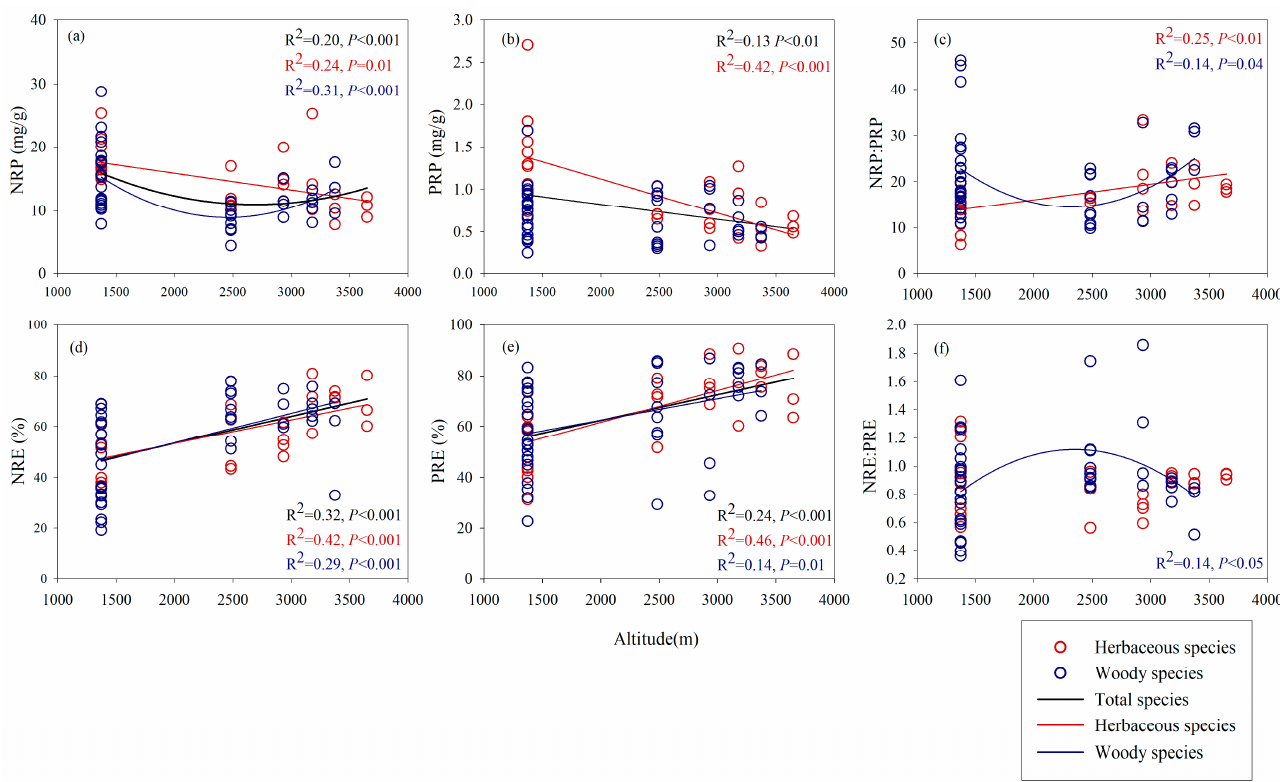
Figure 3. Altitudinal patterns of leaf N and P resorption traits. ( a ) Altitudinal patterns of leaf NRP. ( b ) Altitudinal patterns of leaf PRP. ( c ) Altitudinal patterns of leaf NRP:PRP. ( d ) Altitudinal patterns of leaf NRE. ( e ) Altitudinal patterns of leaf PRE. ( f ) Altitudinal patterns of leaf NRE:PRE. The value of R 2 and p of all significant regressions are given in the figures.